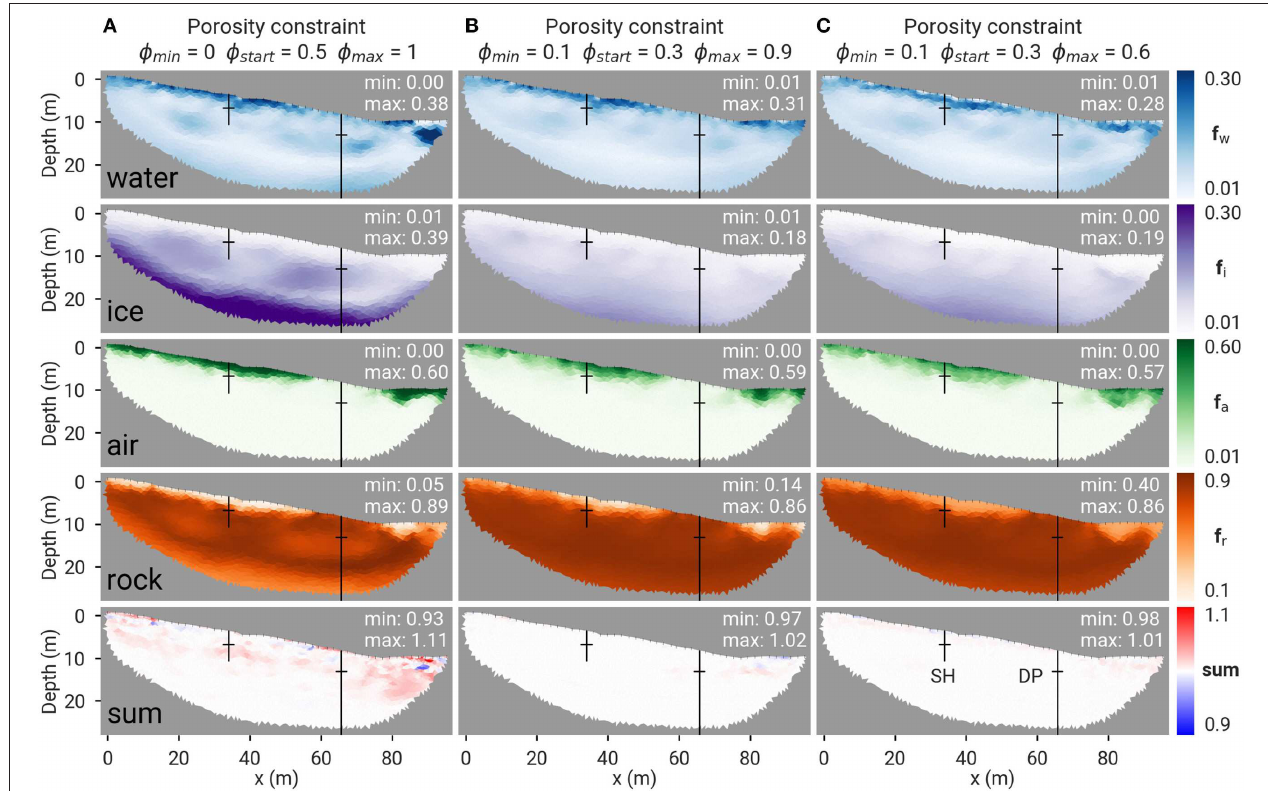
FIGURE 3 | Joint inversion results for the Cervinia profile with volumetric fractions of water f w , ice f i , air f a , rock matrix f r , and their sum using Archie’s law, shown for three different porosity constraints: (A) without a priori knowledge, (B) with a homogeneous start porosity model φ start = 0.3 and excluding extreme values (0.1 < φ < 0.9), and (C) limiting in addition maximum porosity φ max = 0.6. Boreholes and associated thaw depths are marked by black lines. Minimum and maximum phase fractions are indicated for each